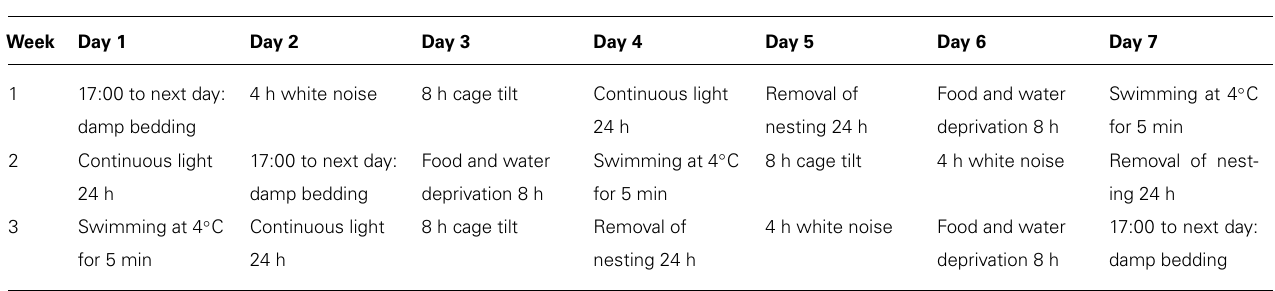
Three weeks prior to cocaine or nicotine conditioned place preference-reinstatement paradigm the mice were randomly assigned the different stressors highlighted in the table. Paradigm is modified from Elizalde etal. (2008); Peng etal. (2012), andTye etal. (2013).